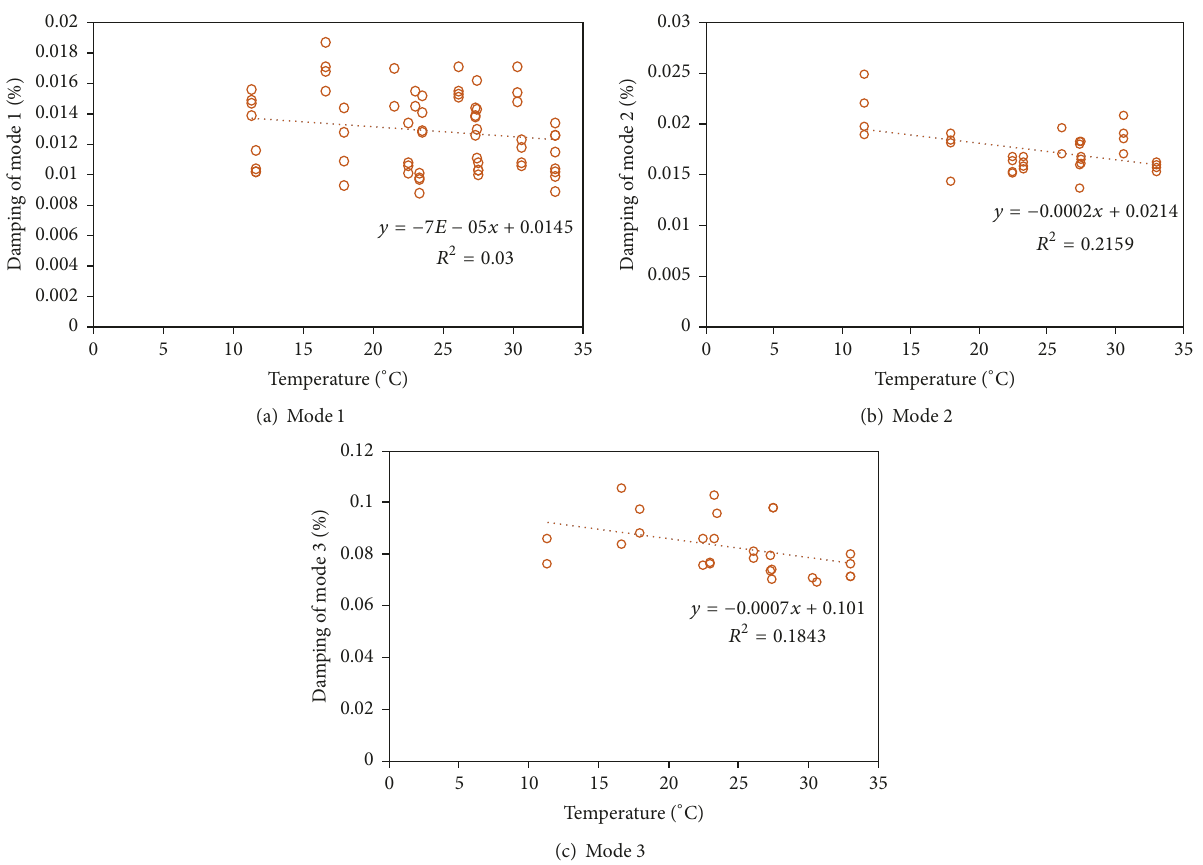
estimate the correlations with the temperature, as reported in previous studies [8, 19,